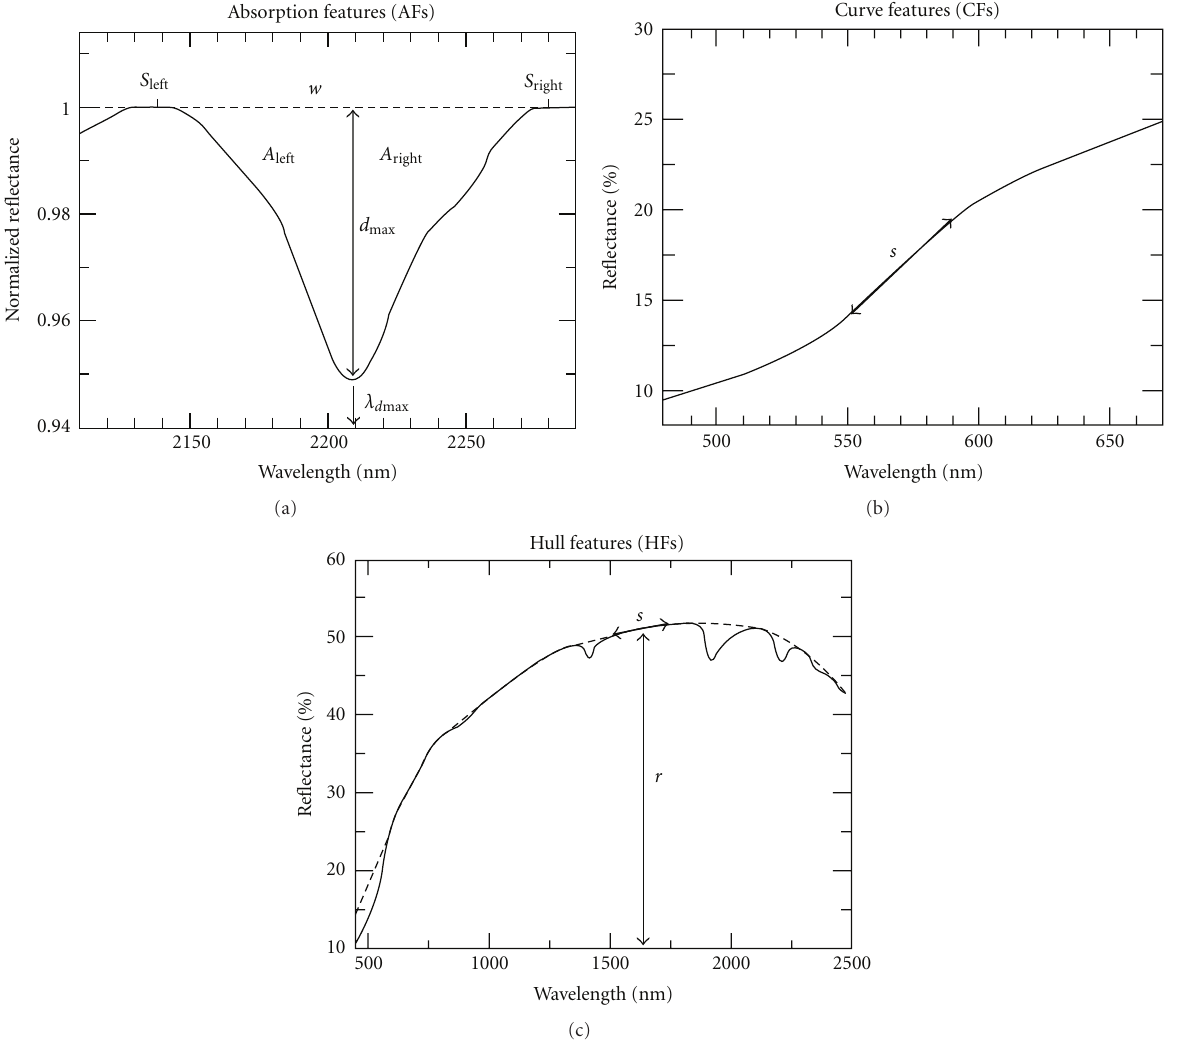
Figure 5: Parameterization of variables for the three types of described spectral features (AF, CF, and HF) used for the determination of soil organic carbon, iron oxides, and clay. Solid line: reflectance curve, dotted: continuum of the reflectance